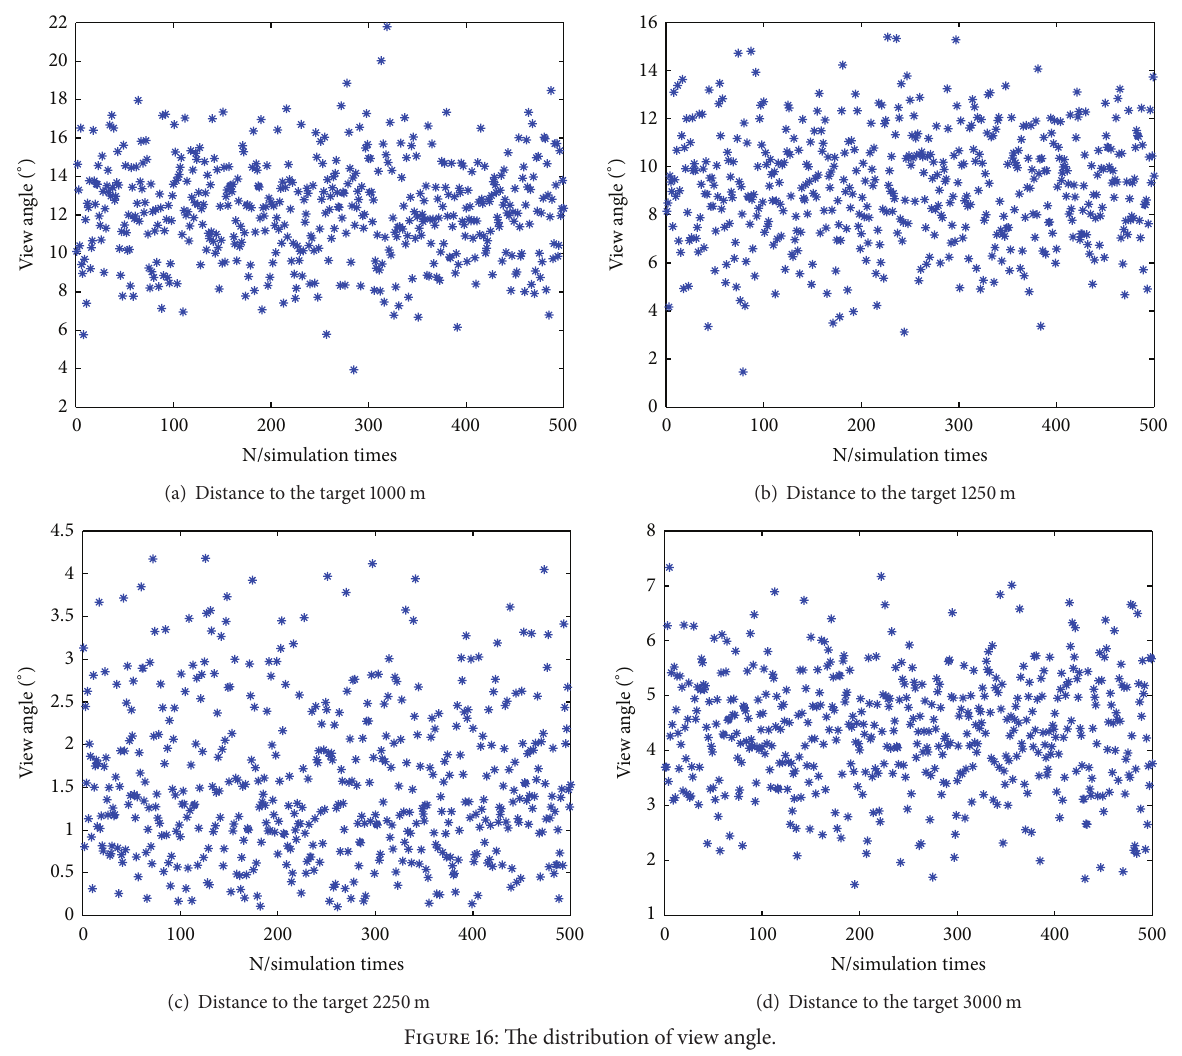
Figure 16: The distribution of view angle.